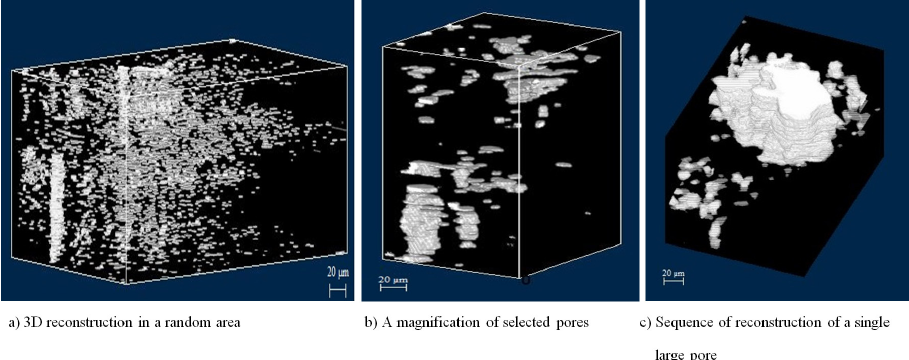
Figure 6. Results of the 3D reconstruction of the pores in a portion of the self-reducing